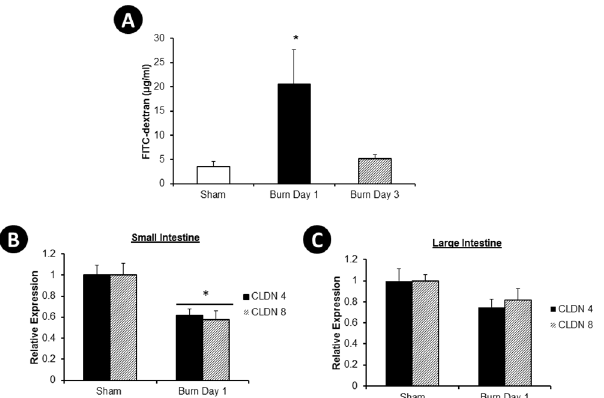
Fig 5. Intestinal Permeability. Sham, burn day 1, and burn day 3 mice were gavaged with FITC-dextran and 3 hours later blood was drawn and the concentration of FITC-dextran was determined spectrophotometrically in the plasma ( A ). RNA was purified from the distal small ( B ) and large ( C ) intestine one day after burn, reverse transcribed and quantified with qPCR using primers for claudin (Cldn 4, and Cldn 8), in combination with endogenous control Gapdh. Δ Ct values were calculated and the mean ± SEM of 10 – 15 animals/group was expressed relative to sham. ( A ), * , p < 0.05 ANOVA followed by Tukey-Kramer multiple comparisons post hoc test of sham and burn day 1. ( B ), unpaired student t-test sham and burn day 1, * p <